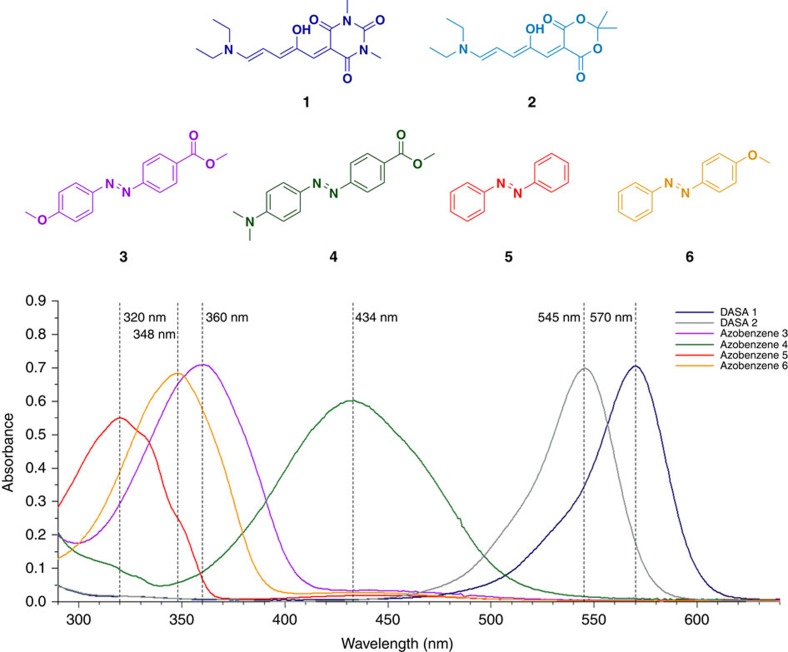
Structural scope of photoswitches.Structural scope of DASAs (1 and 2) and azobenzenes (3–6). Overlay of the ultraviolet-visible absorption spectra of compounds 1–6 (compounds 1 and 2: ∼4 μM; compounds 3–6: ∼20 μM; toluene; room temperature) with their corresponding absorption maxima.